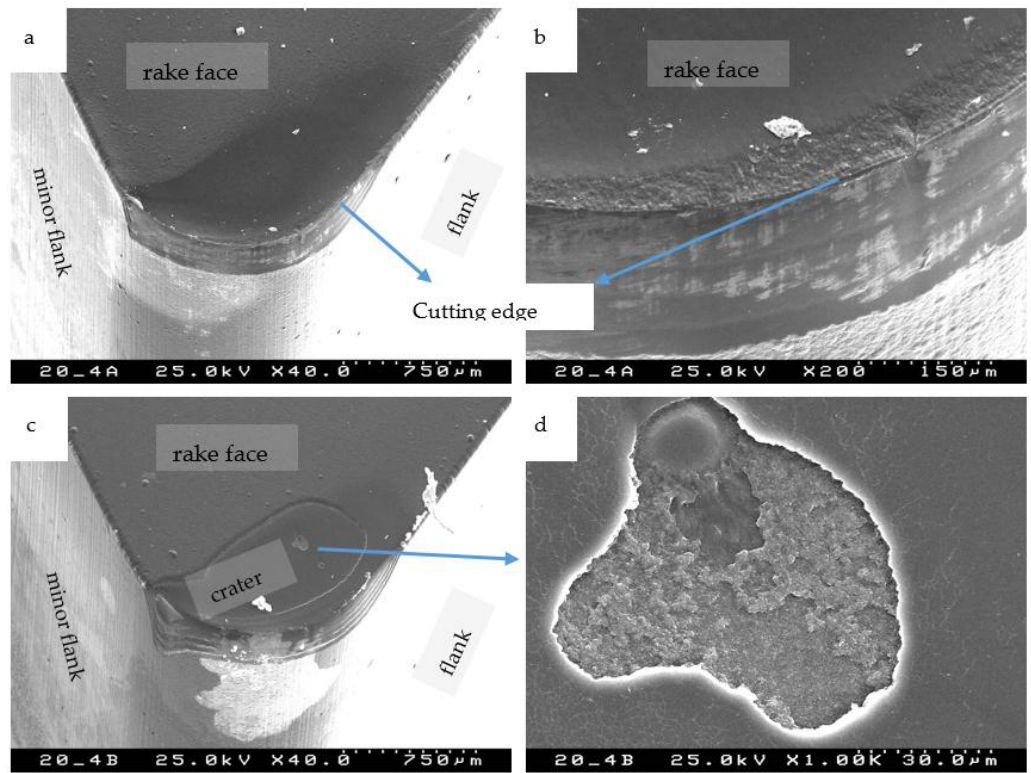
Figure 5. ( a ) SEM micrographs of the ML10x2 cutting inserts after machining at v = 500 m·min −1 , DOC = 1.0 mm, f = 0.3 mm·rev −1 : ( a , b ) L = 1975 m (four pass, dry ); ( c , d ) L = 1878 m (four pass, lubricated).